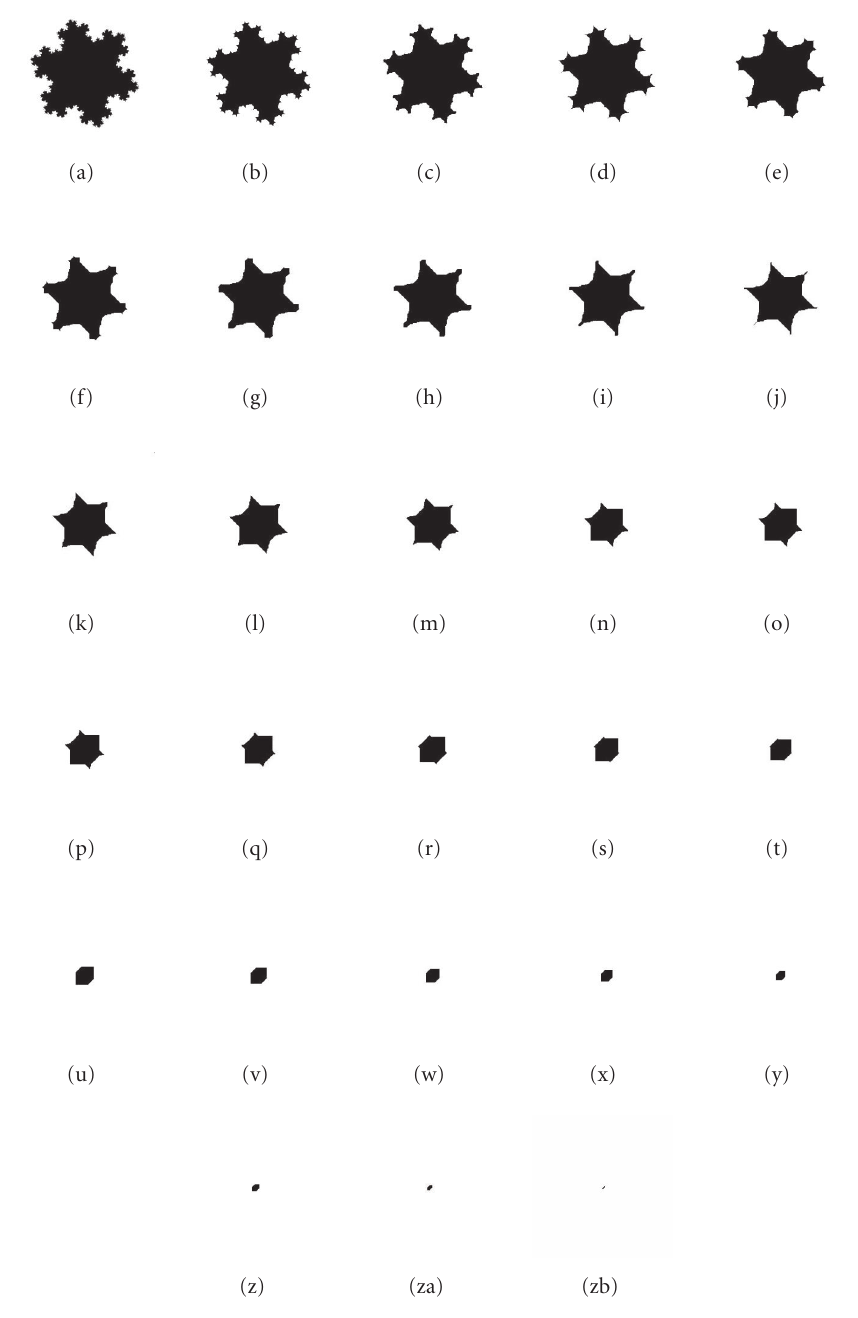
Figure 2.3. Fractal pore under increasing cycles of erosion transformation by octagon structuring